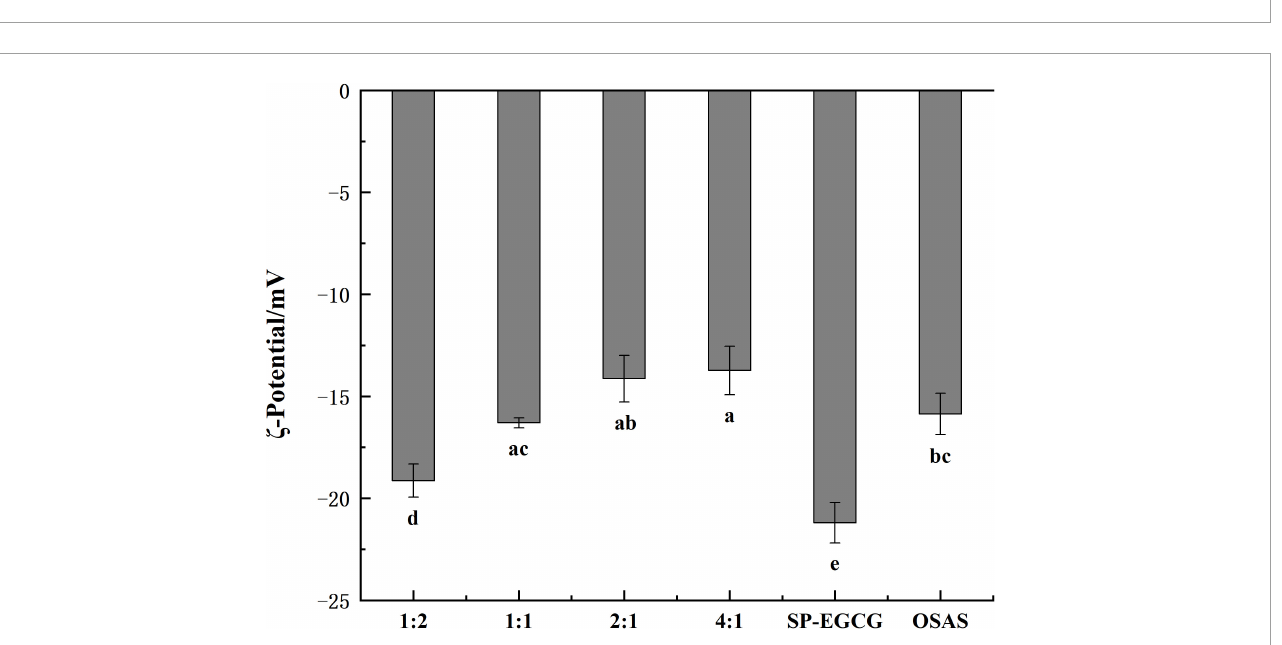
FIGURE2 The ζ -potentials for OSAS-SP-EGCG complexes, SP-EGCG complexes and